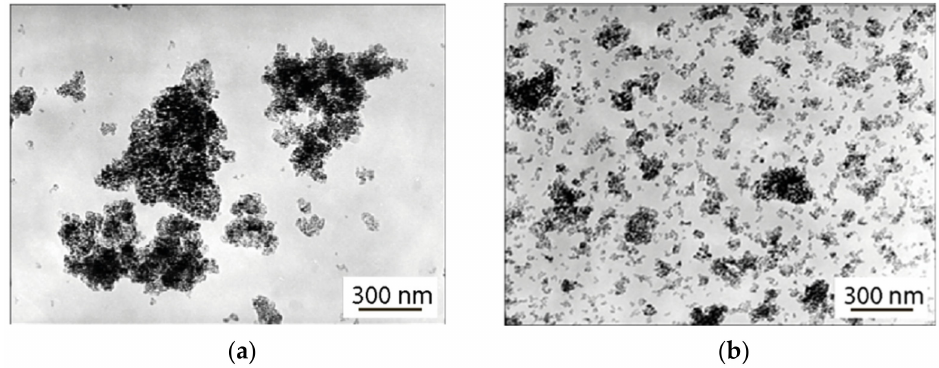
Figure 2. TEM images of nanopowders of the composition ZrO 2 —3% mol Y 2 O 3 , obtained at annealing temperatures of 400 ◦ C, during 2 h. ( a ), and 500 ◦ C during 2 h ( b